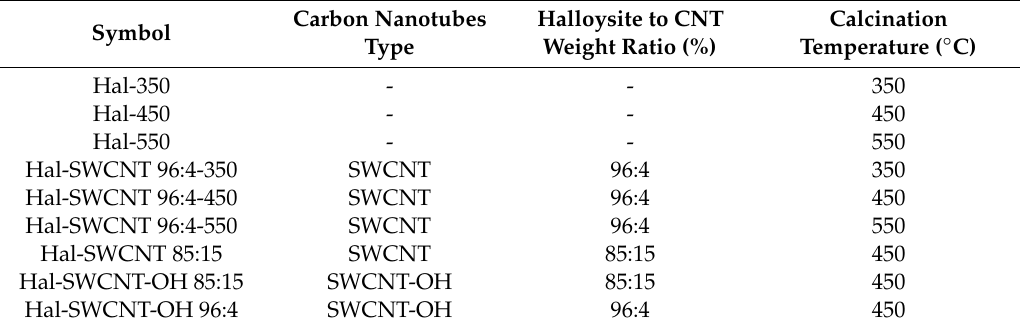
Table 3. Types of the thermally treated samples and their preparation